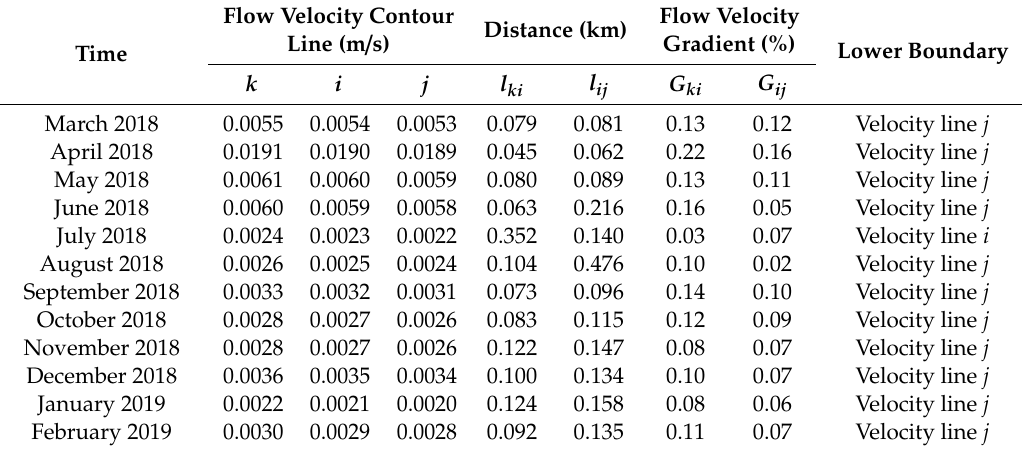
Table 2. Calculation of the flow velocity gradients G ij and G ki in the Fu River–Baiyangdian Lake transition zone. Figure 5 shows the positions of lines k , i , and j .